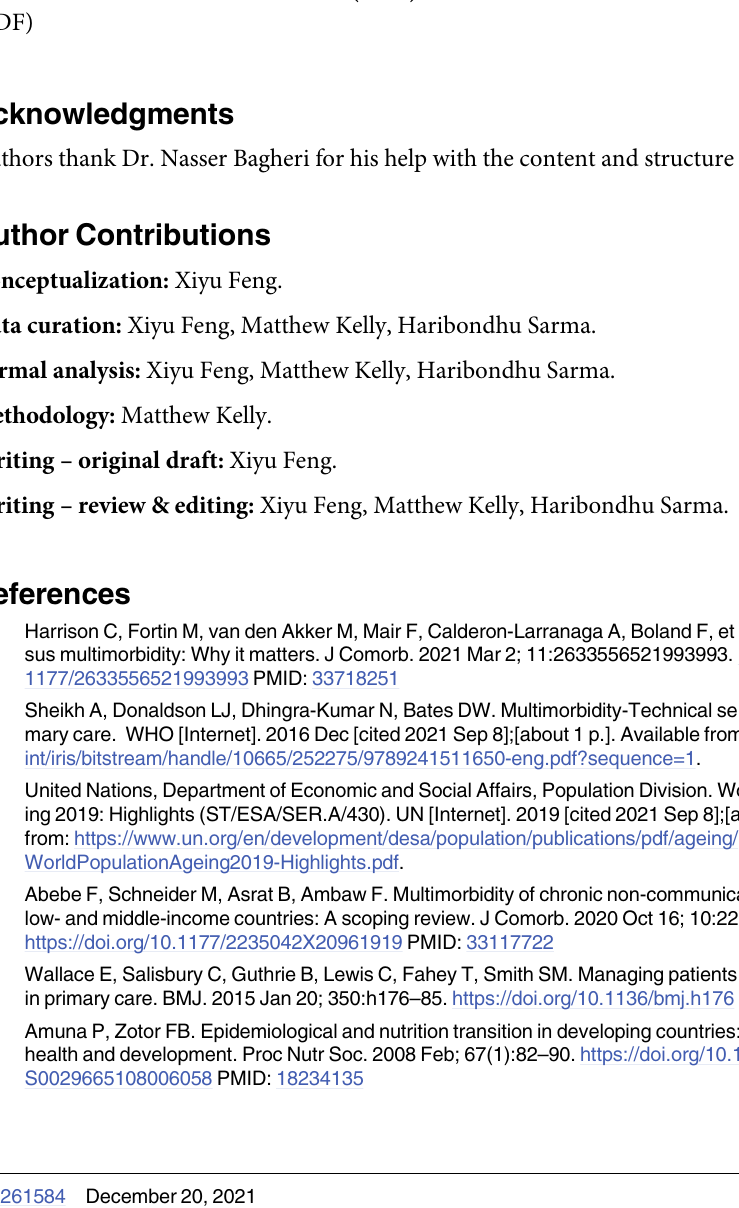
S1 Table. Search query of databases. S2 Table. NOS checklist for selected studies (cross-sectional study). S3 Table. PRISMA 2009